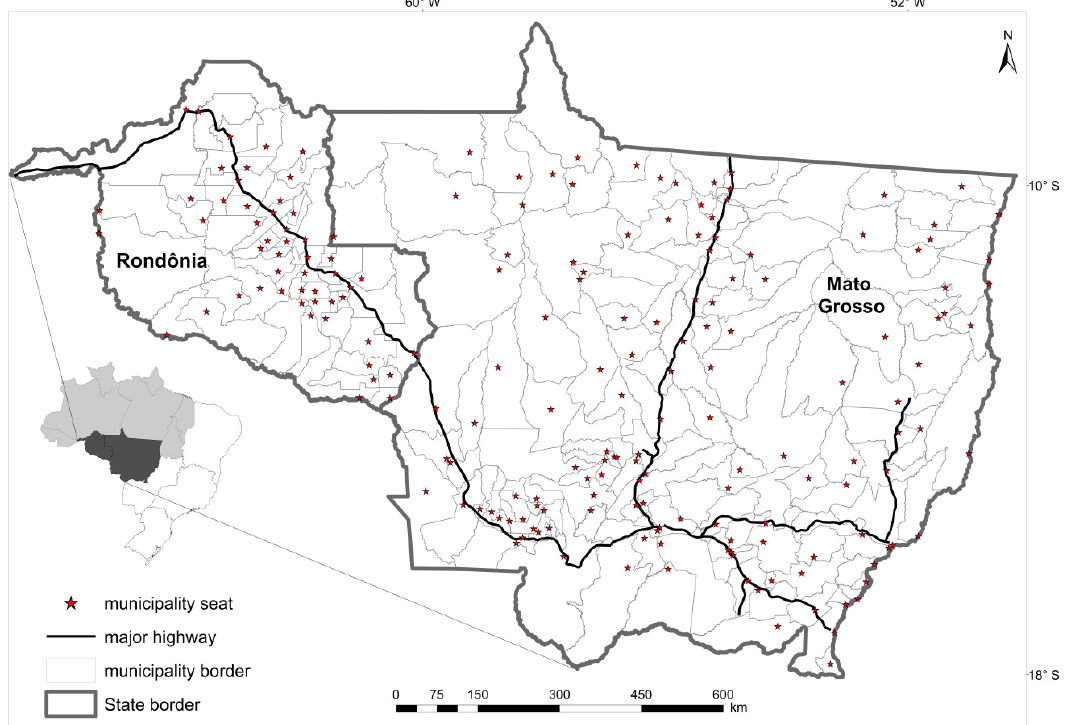
Figure 1. Study area location indicating major highways, main urban areas (municipality seats) and political borders of municipalities in Rondônia and Mato Grosso